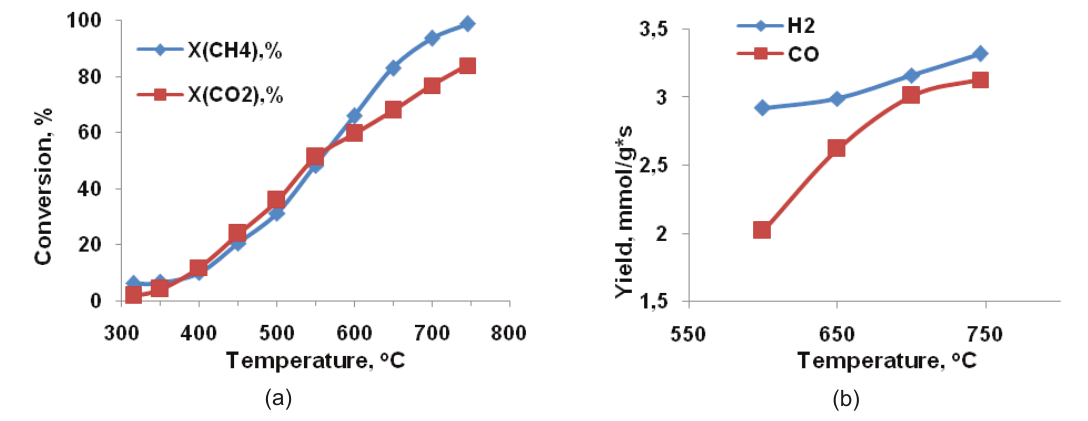
Figure 3. Effect of temperature on the steam reforming of biogas over the 5%(Co-M